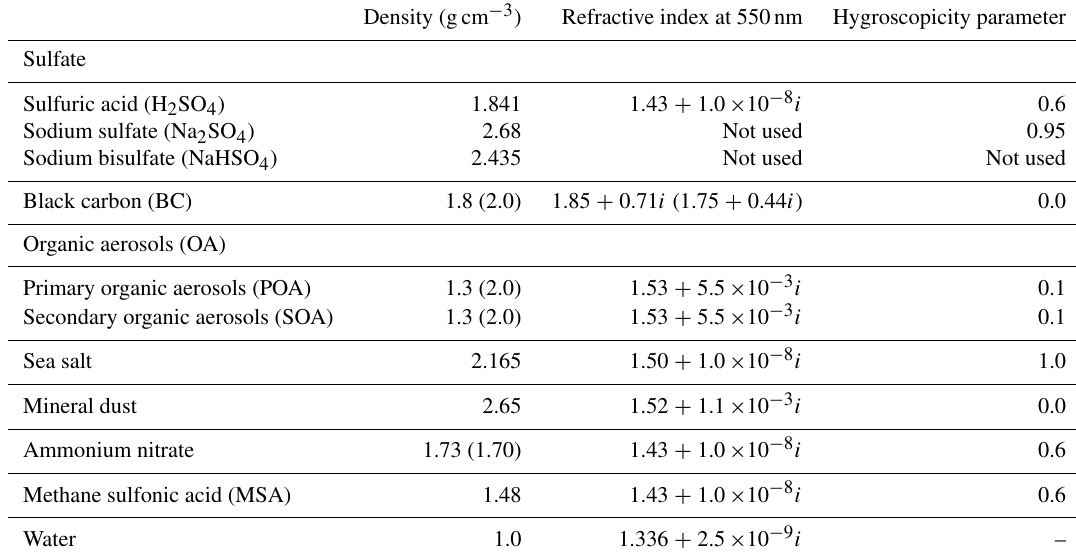
Table 1. Physical properties of the various aerosol components included in the model. For properties that have been updated, the numbers in parentheses indicate the values used in the earlier TM5 and EC-Earth versions documented in van Noije et al.